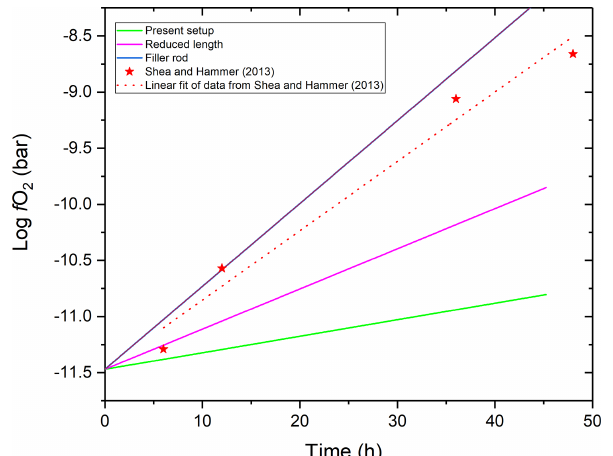
Figure 10. The time-dependent variation of f O 2 in a capsule in the MHC pressure vessel at a water activity of 1 and T = 1000 ◦ C. To allow comparison, we used the value of Shea and Hammer